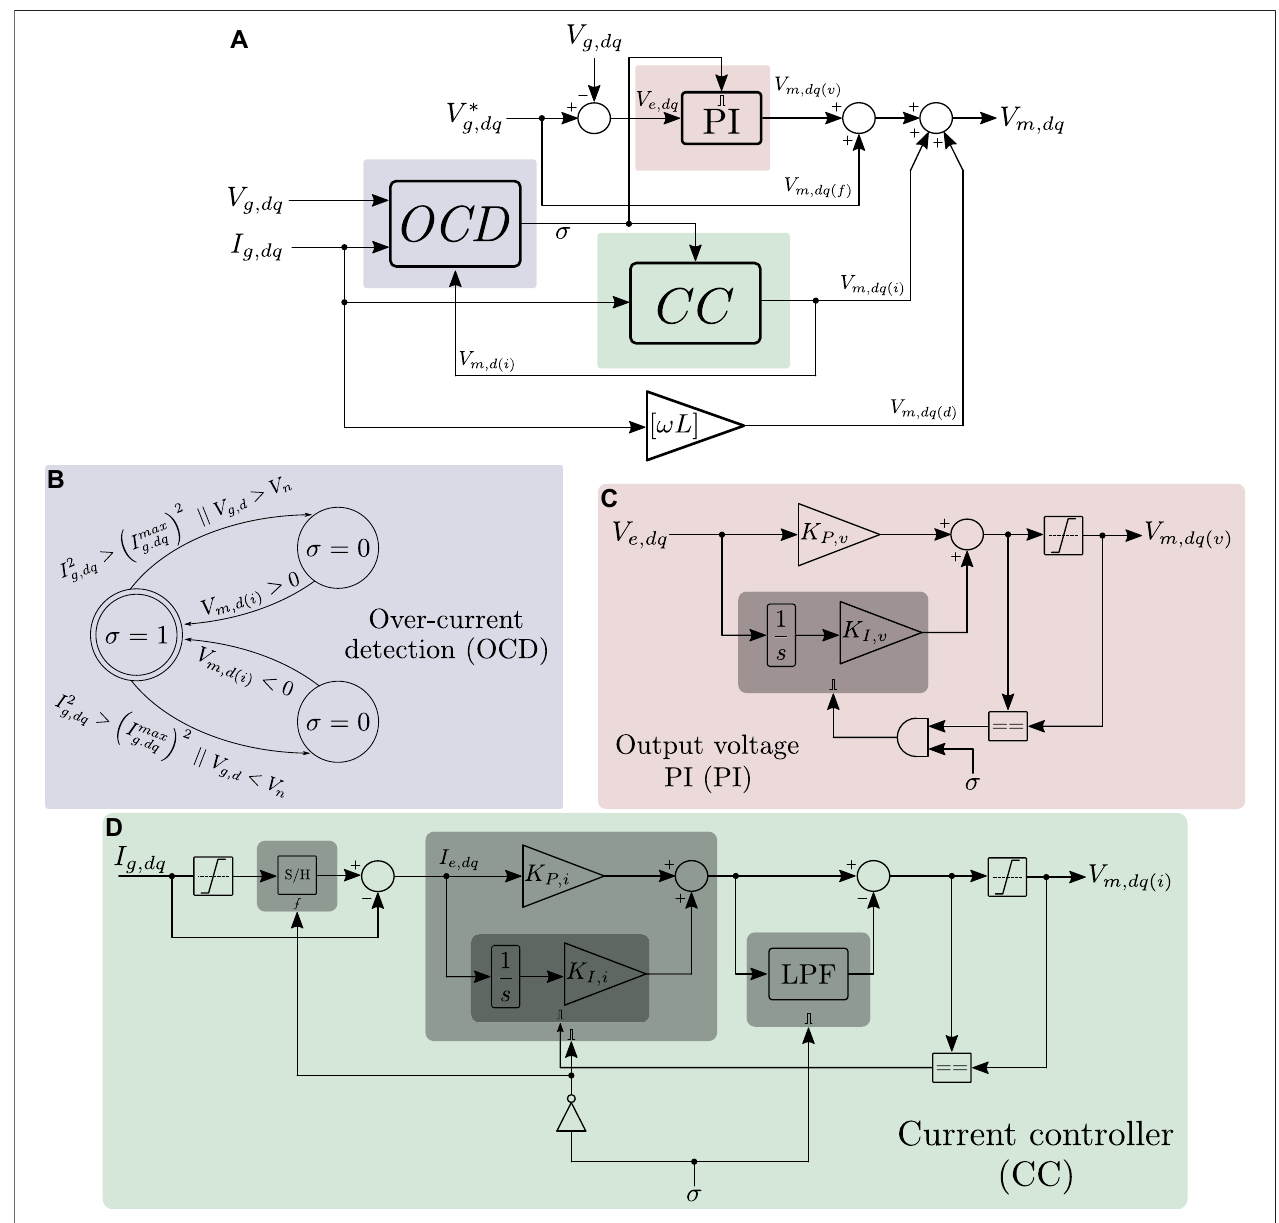
FIGURE3| Grid-formingvoltageandcurrentcontrolblockdiagramwithover-currentdetectionandregulator. (A) completecontrolloop, (B) overcurrentdetection state machine, (C) output voltage PI, and (D) current control loop.